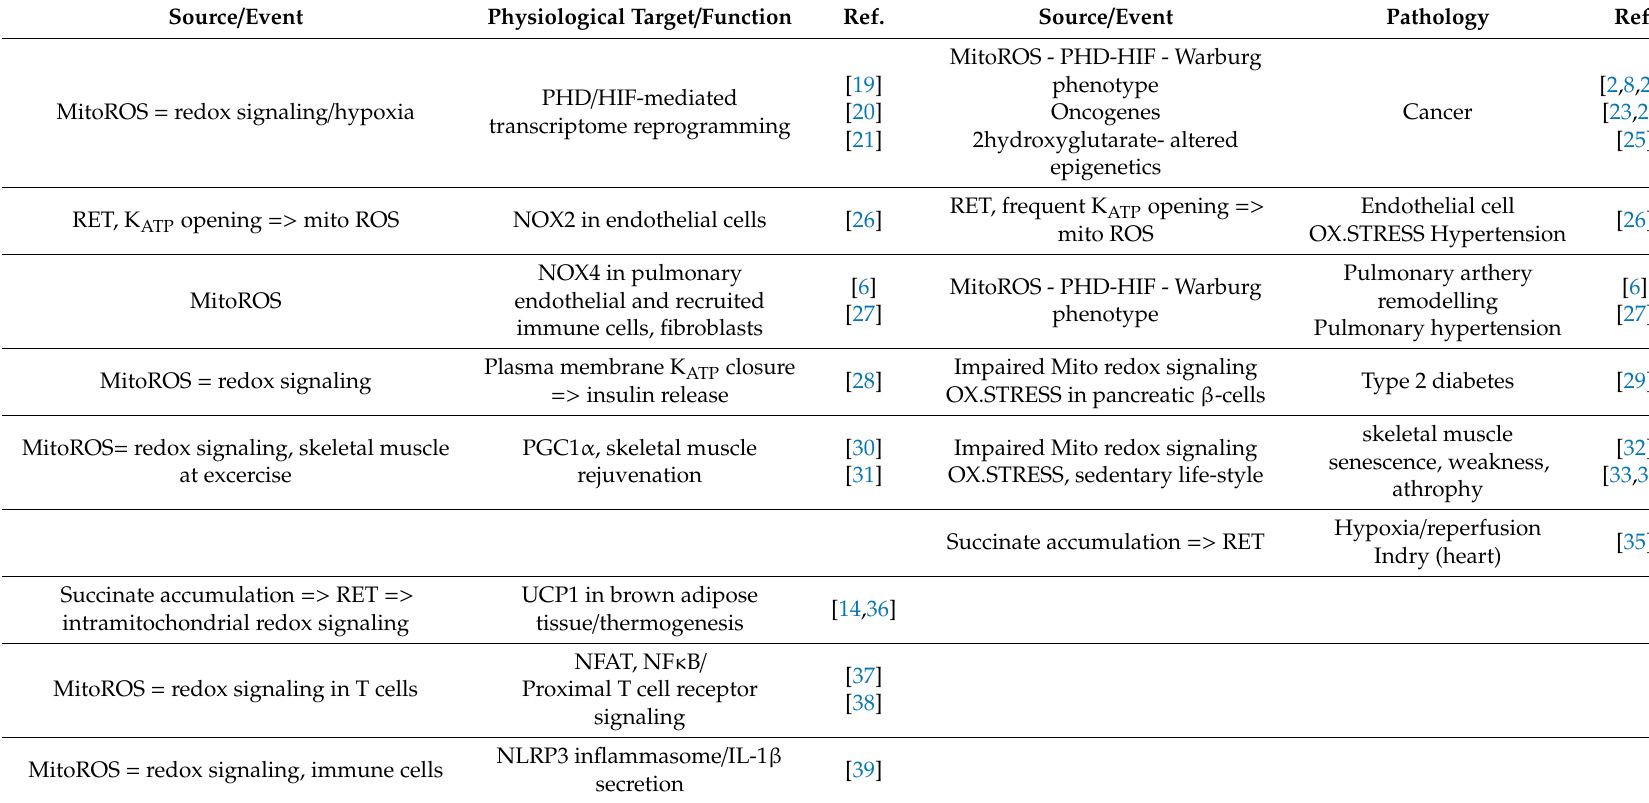
Table 1. Exemplar physiological situations with mitochondrial redox signaling and possible pathological consequences of its exaggeration and / or